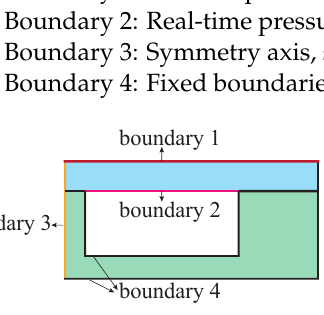
Figure 4. Microhemispherical shell forming process and key structural parameters before and after